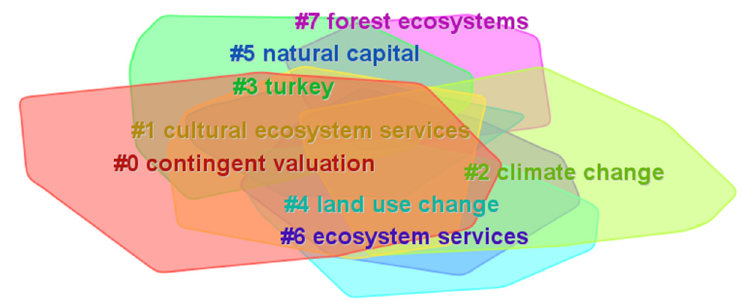
Figure 6. Keyword clustering analysis network.